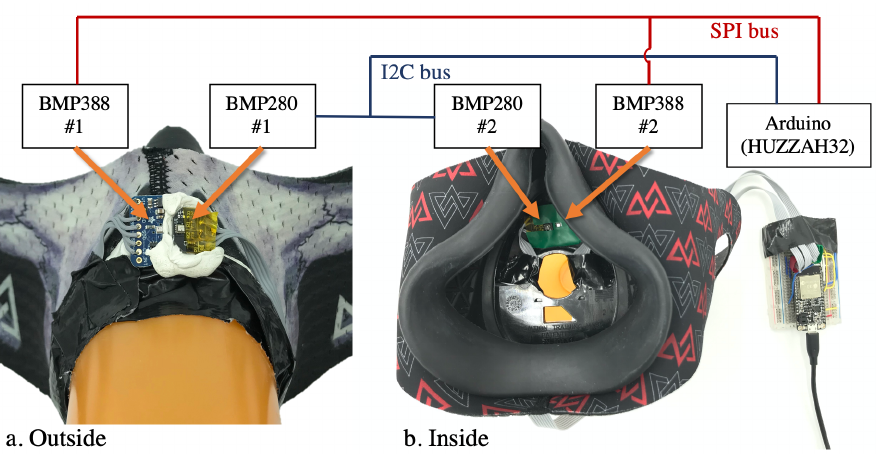
Figure 4. The hardware and communication structure during The experiment: outside view ( a ) and inside view ( b ) of The facemask.